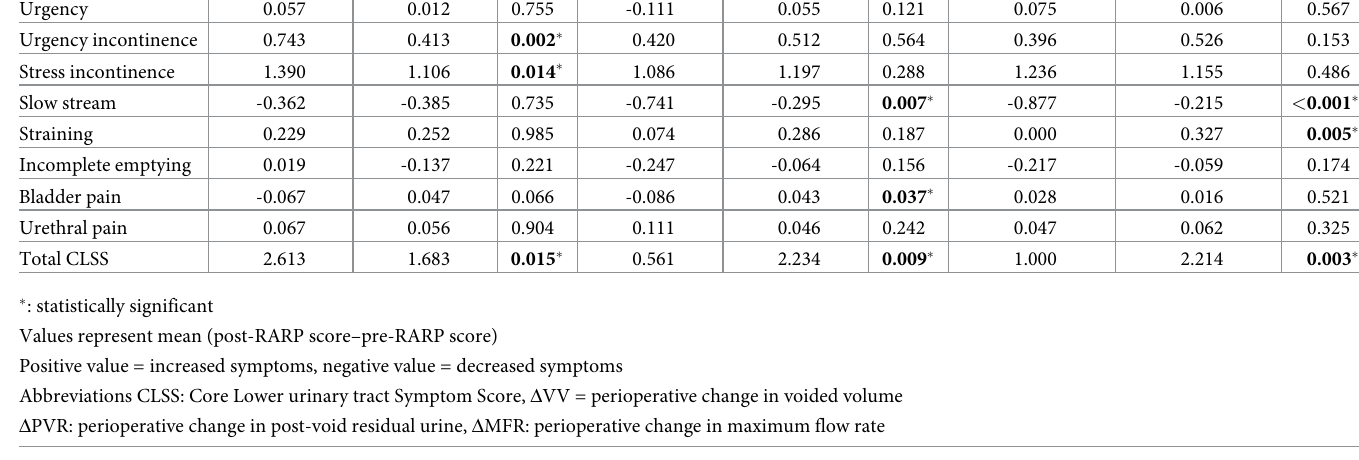
Values represent mean (post-RARP score–pre-RARP score) Positive value = increased symptoms, negative value = decreased